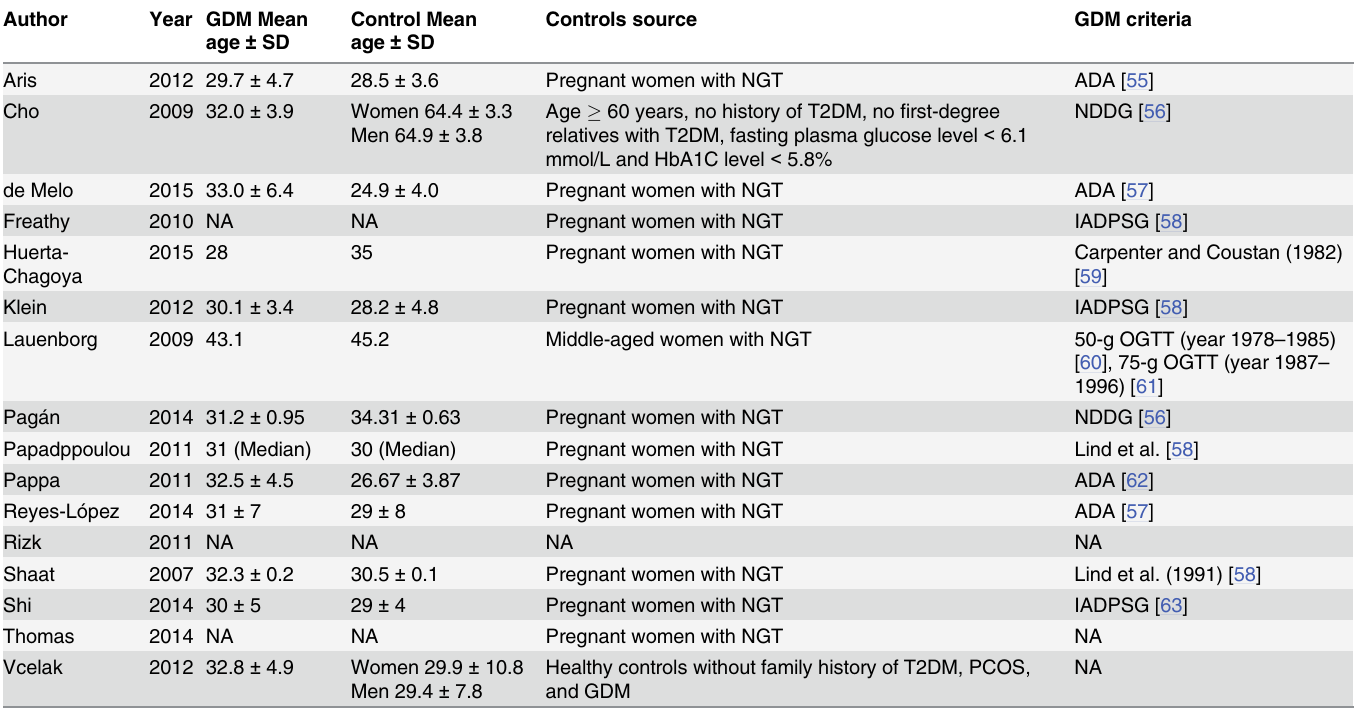
Table 1. Characteristics of 4,853 GDM cases and 10,631 controls included in this meta-analysis.